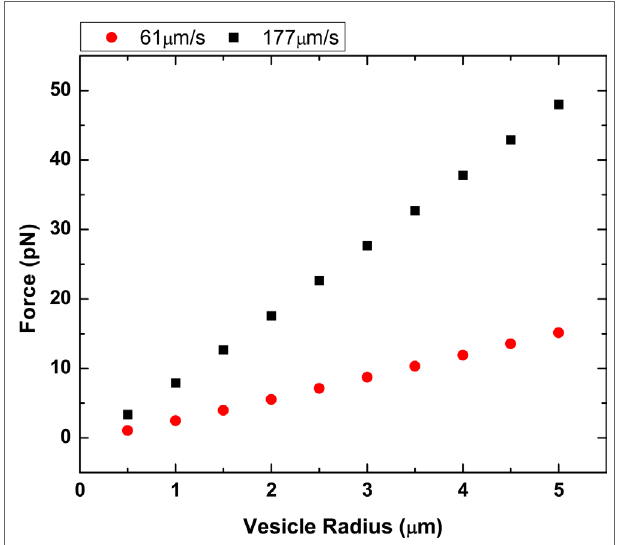
FigUre 5 | Plot of vesicle radius vs. drag force . Two different flow rates at 61.3 and 177.6 μ m/s were plotted using both Stoke’s law and Faxen’s